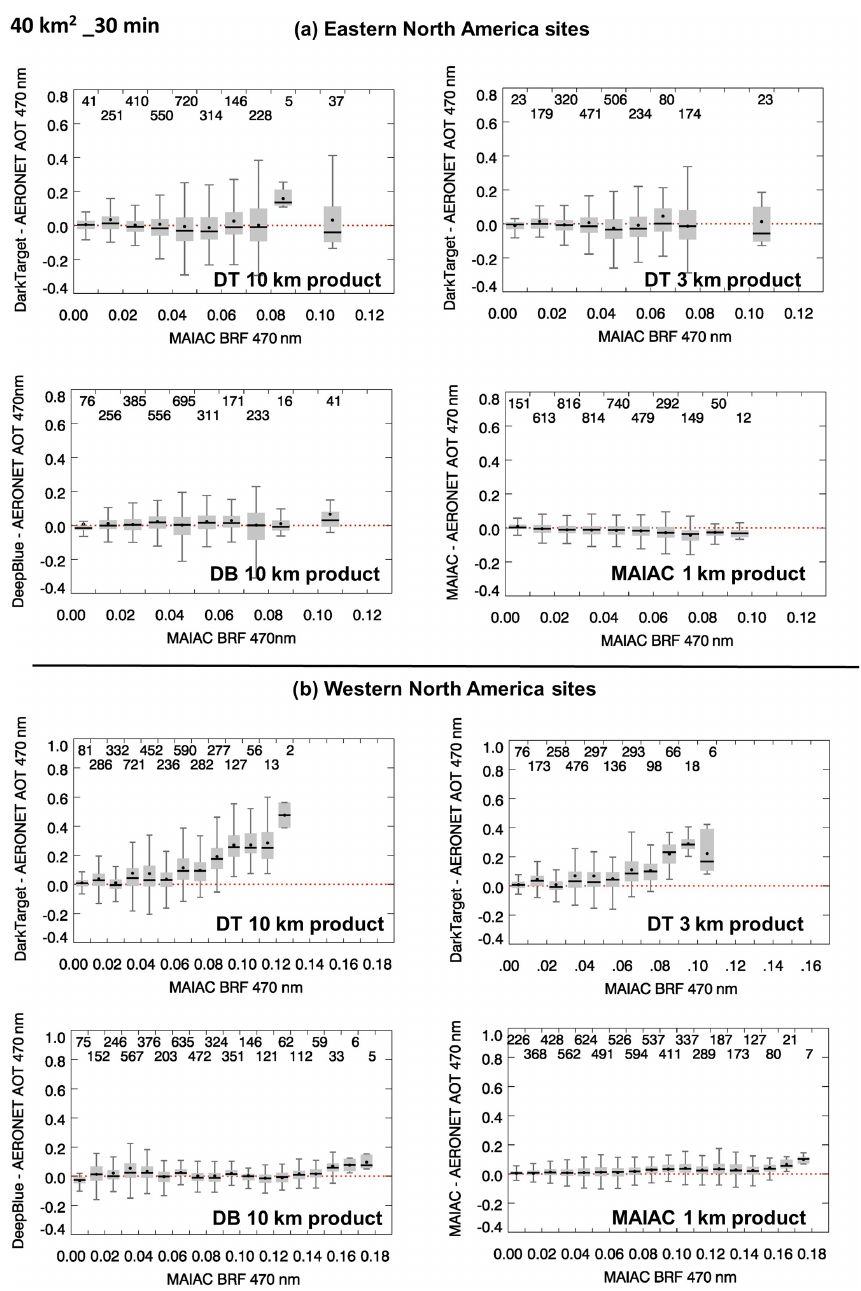
Figure A1. Difference in AOT (470nm) between MODIS and AERONET as a function of coincident bidirectional reflectance retrievals (470nm) from the MODIS MAIAC product for eastern NA (a) and western NA (b) . Data are represented as a box-and-whisker plot with the thick horizontal line as the median, black dot as mean, shaded boxes covering the 75th and 25th percentiles, and vertical lines as 1.5 times the interquartile range (25–75th percentiles). The number of matchups for each bin is shown at the top of the